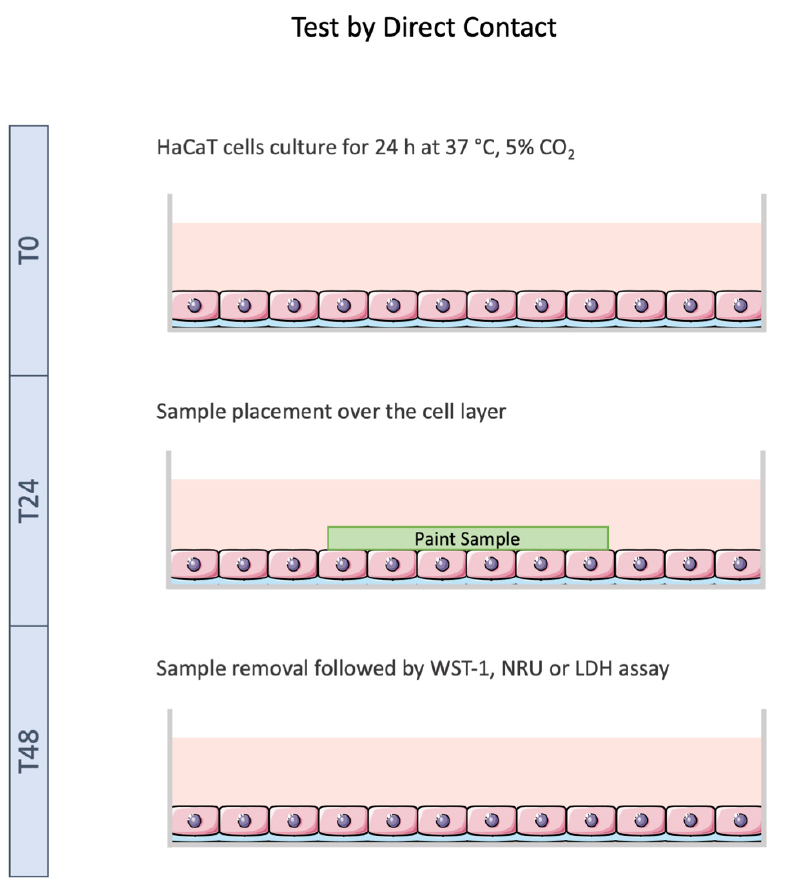
Figure 1. Schematic representation of test by direct contact performed with HaCaT cell line. Cells were exposed to the samples for 24 h followed by cytotoxicity assays. Image not to scale. Briefly, HaCaT cells were seeded in 6-well plates (1.0 × 10 5 cells/mL) and allowed to adhere for 24 h at 37 °C, 5% CO 2 . Afterwards, complete medium was replaced with fresh assay medium (DMEM + 5% ( v / v ) FBS), and the samples (Un_Paint, TCS, ISB, W and Cu 2+ ) were smoothly placed over the cell layer, in direct contact with cells. After, the cells were incubated for 24 h. Thereafter, the samples were smoothly extracted from the wells and cellular viability and membrane integrity were assessed as detailed in the following Sec- tions 2.6.1–2.6.3.